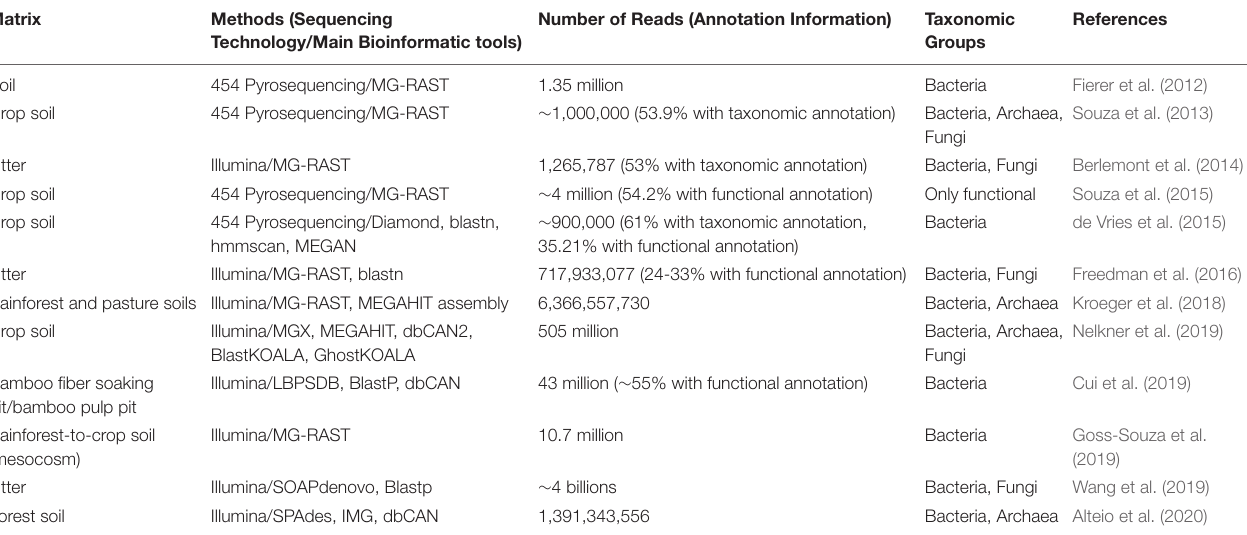
TABLE 4 | Selected metagenomic studies indicating number of reads using different sequencing technologies for a variety of materials from biological situations that present similarities to retting.